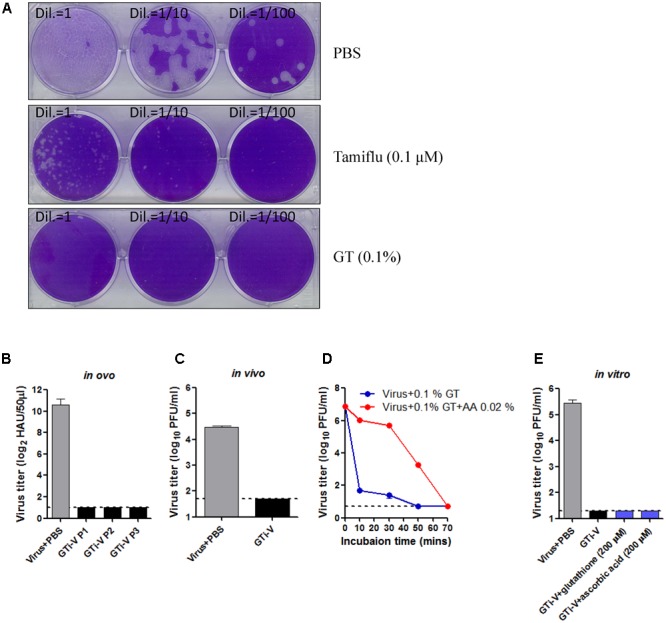
Irreversible inactivation of influenza virus by GT treatment. (A) Inactivation of the plaque-forming ability by GT treatment. 1,000 PFU of PR8 virus was incubated with PBS, Tamiflu (0.1 μM), or GT (0.01%) for 6 h at RT. A 10-fold dilutions of the mixtures were then subjected to plaque assay on MDCK cells. The plates were incubated at 37°C for a week before fixation and staining. (B–E) Validation of the irreversible inactivation of influenza virus by GT treatment. (B) Validation in ovo. PR8 virus (5 × 107 PFU) was incubated with PBS or GT (0.1%), and the mixtures were injected into embryonated chicken eggs and incubated for 3 days at 37°C. Allantoic fluids were harvested at each passage for viral titration by hemagglutination assay. Data are the means of three independent experiments. (C) Validation in vivo. PR8 virus (2.5 × 106 PFU) was incubated with PBS or GT (0.1%), and the mixture was intranasally injected into mice (n = 3). Four days later, the lungs were taken from the mice for viral titration by plaque assay. (D) Time-course of viral inactivation by GT in the presence of ascorbic acid. PR8 virus (5 × 107 PFU) was incubated with GT (0.1%) and ascorbic acid (0.02%) at 25°C, and the mixtures were harvested at various time points for viral titration by plaque assay. Data are the means of three independent experiments. (E) Validation in vitro. PR8 virus (1 × 106 PFU) was incubated with PBS or GT (0.1%) for 2 h at 35°C. After viral inactivation, 200 μM glutathione or ascorbic acid was added to the mixtures and incubated for 2 h at 37°C. The final mixtures were subjected to plaque assay for viral titration. Data are the means of three independent experiments.